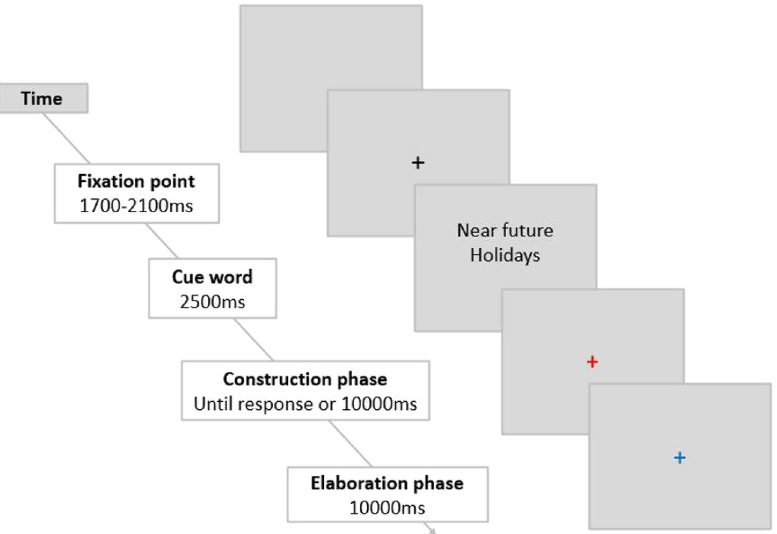
Figure 1. Stimuli and timing in a given experimental trial. Participants had up to 10 s to evoke a unique event related to the word cue (construction phase). They were asked to terminate the construction phase by pressing the spacebar as soon as they had generated the event, which led them to the elaboration phase (10 s long), in which they had to fill the event with as much detail as possible.